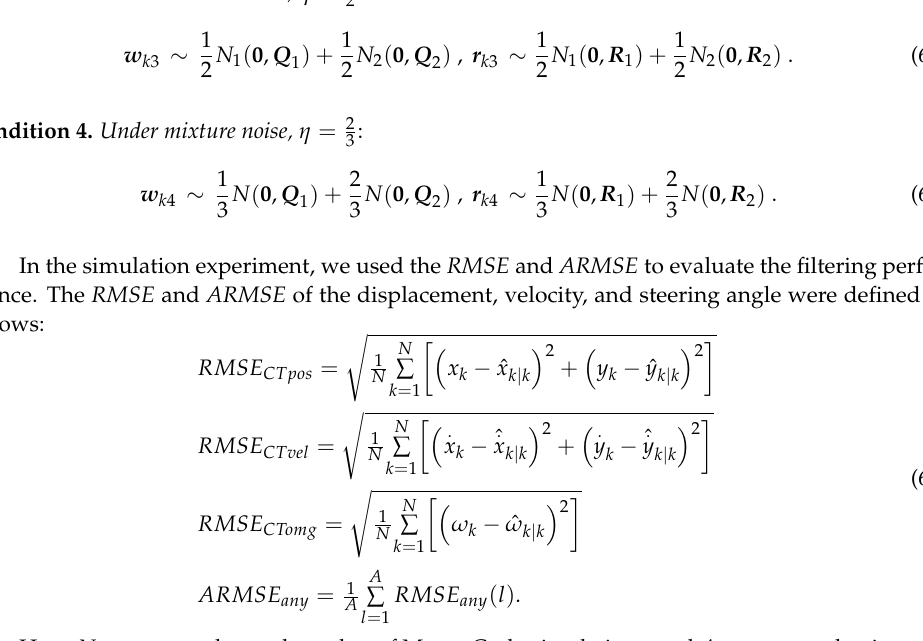
( b ) Figure 8. Position RMSEs of robust target-tracking algorithms under non-Gaussian noise condi- tions (( a ) is the result under Equation (65) and ( b ) is the result under Equation (66)) . ( a )